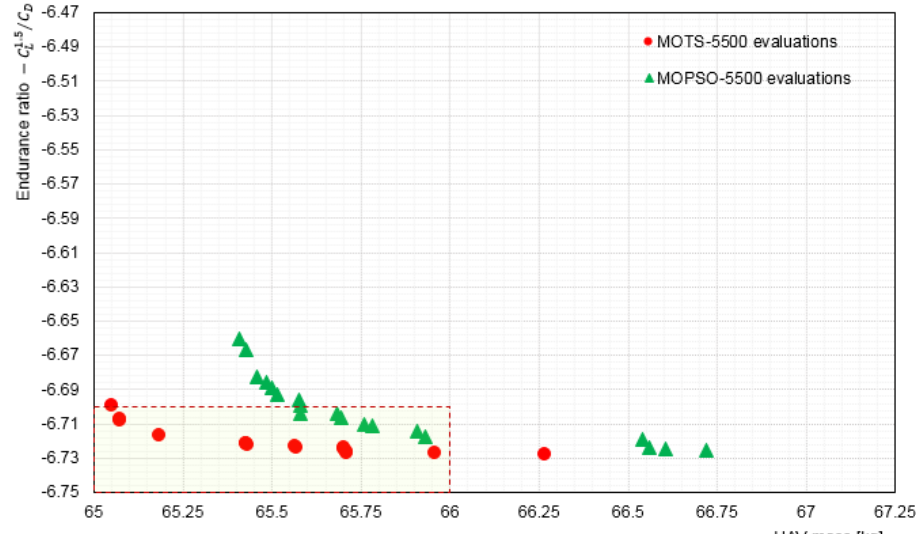
Figure 14. Pareto front using MOTS and MOPSO for 5500 evaluations. Note that the red dashed box represents the ROI when performing the optimisation interactively. Aerospace 2019 , 6 , 42